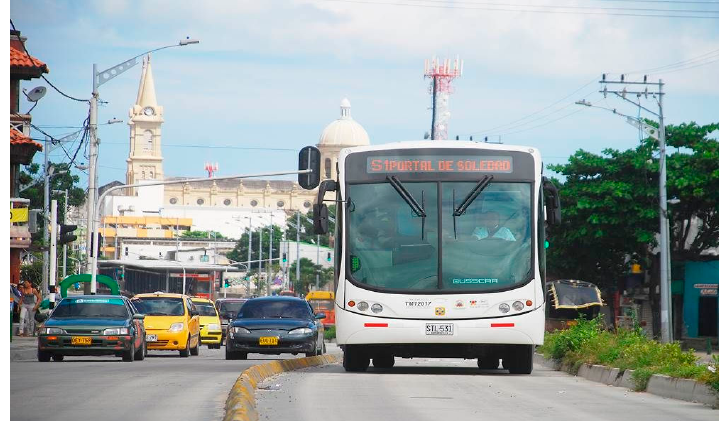
Figure 7. Baranquilla’s BRT system.